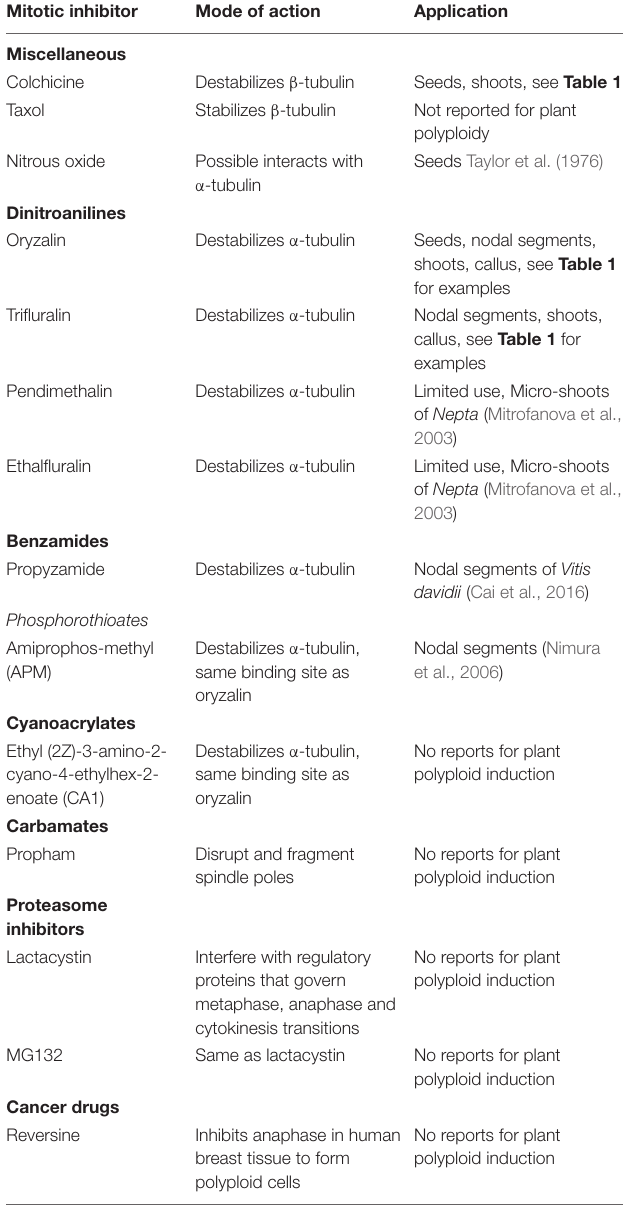
TABLE 2 | Mitotic inhibitors that are used or have potential to interfere with the cell cycle to induce